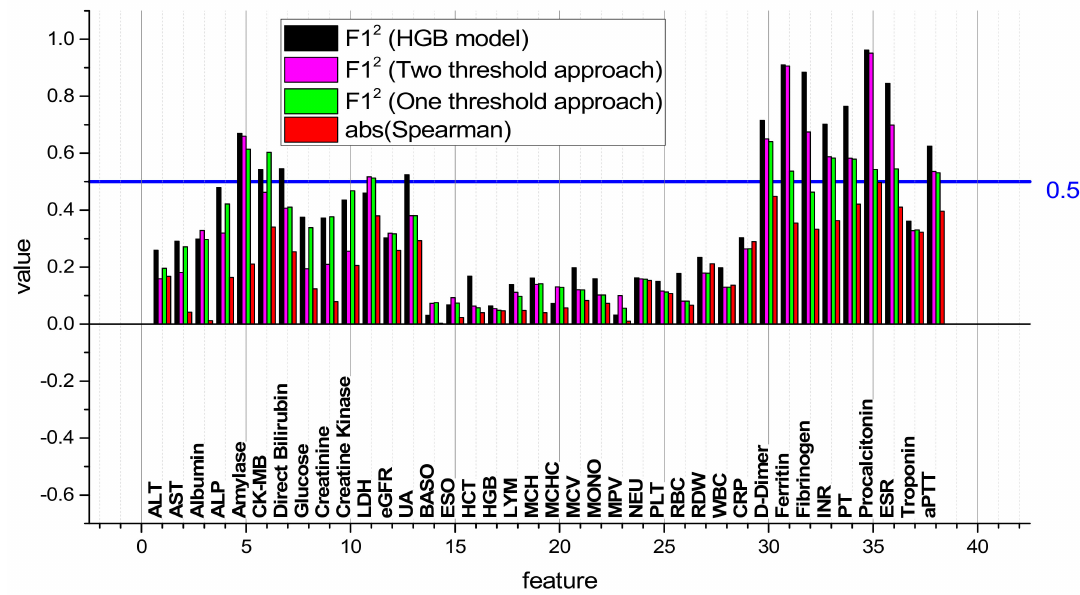
Figure 11. F1 2 metric of SARS-CoV-2-RBV3 dataset for different models. 3.5. Investigation of the Effectiveness of the HGB Model Working on Two Features for the Detection of Surviving and Non-Surviving COVID-19